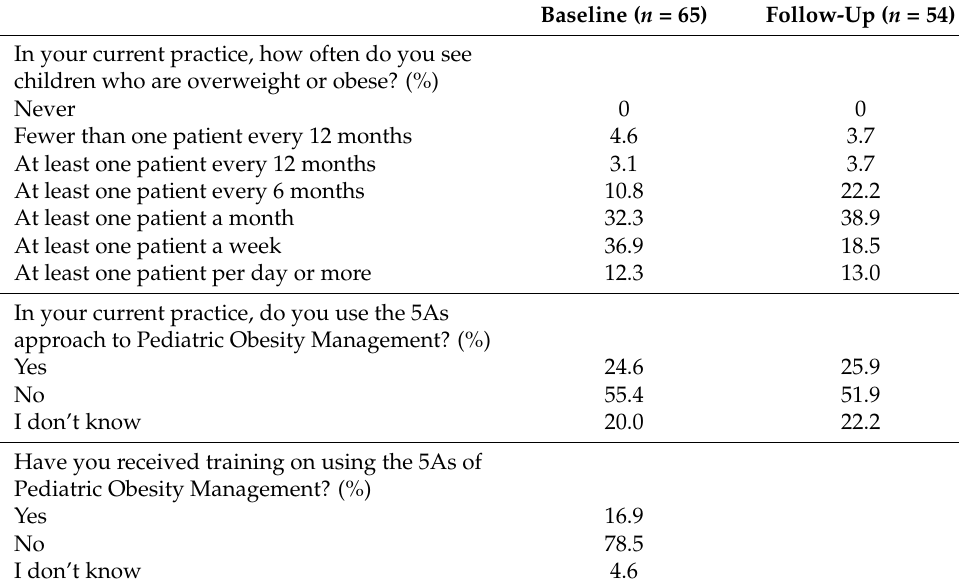
Table 3. Questions about current practice and